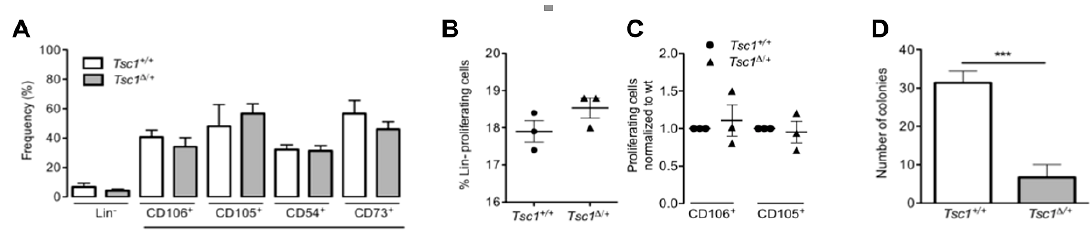
Figure 3. The population of BM-MSCs is no longer expanded in Tsc1 ∆ /+ aged mice. ( A ) Cell population frequency, by flow cytometry of BM-Lin - cells immediately after isolation from 1.5 yr old Tsc1 +/+ and Tsc1 Δ /+ mice. Lin - and Lin - CD106 + , -CD105 + , -CD54 + , and -CD73 + subpopulations are shown. ( B ) Percentage of proliferating BM-Lin - cells, by BrdU incorporation, in Tsc1 +/+ and Tsc1 Δ /+ 1.5 yr old mice. ( C ) Percentage of proliferating cells within Lin - CD106 + and Lin - CD105 + subpopulations. ( D ) CFU-F assay of BM-Lin - cells isolated from 1.5 yr old mice. Panels A–C: Data shown are means ± SD, n = 3 mice per group. Panel D: Data are triplicate measurements of pooled BM-MSCs for both genotypes ***, p < 0.001.